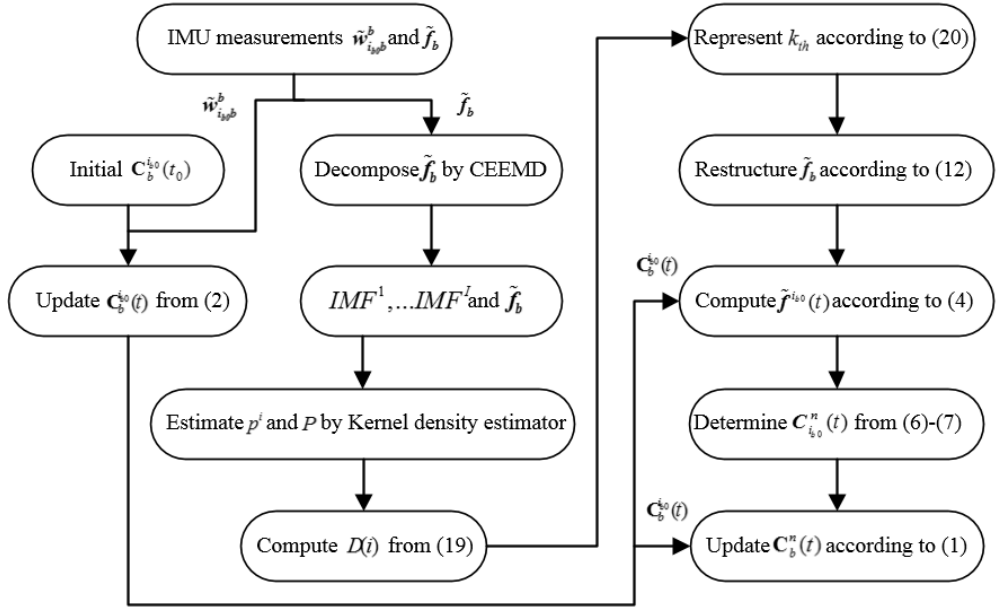
Figure 6. Process of the proposed algorithm.